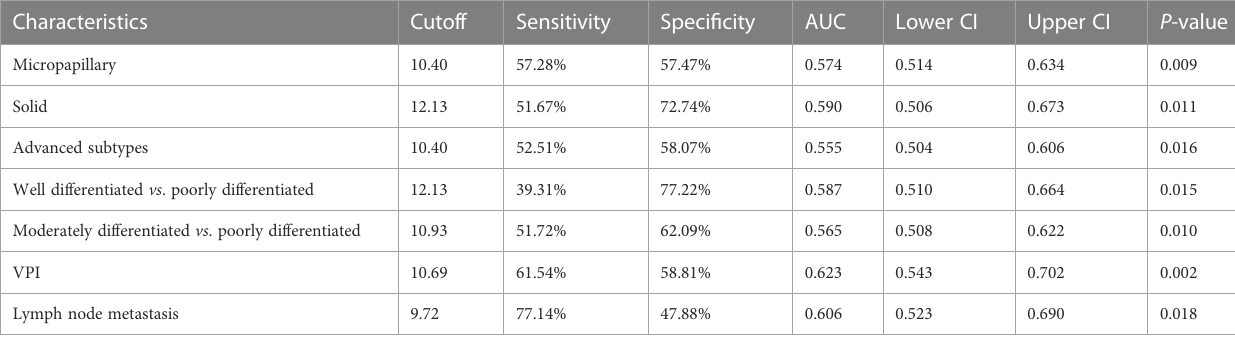
TABLE 2 Optimal cutoff, sensitivity, speci fi city, and AUC of ROC curves. Characteristics